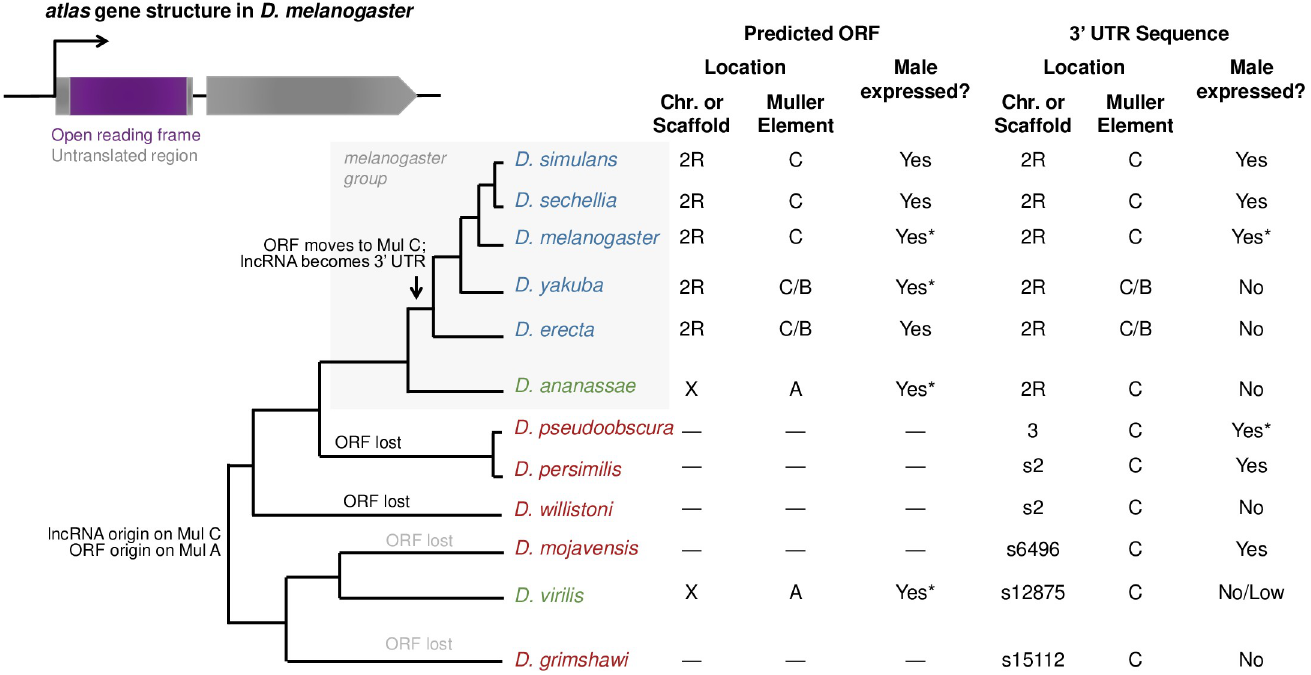
Fig 7. Molecular evolution and gene expression of atlas across the Drosophila genus. The gene structure of atlas in D . melanogaster is shown at top left. The predicted protein-coding sequence is contained entirely within exon 1, while exon 2 encodes the presumed 3’ UTR. The gene is located on chromosome 2R, equivalent to Muller element C. The phylogeny shows BLAST- and synteny-based detection of sequences orthologous to the protein-coding sequence and the 3’ UTR sequence across Drosophila species. Sex-specific adult RNA-seq data were used to assess male expression across species, with RT-PCR verification performed in species marked with asterisks. RNA-seq data for the syntenic region of the 3’ UTR in D . virilis were ambiguous; see S8 and S10 Figs.